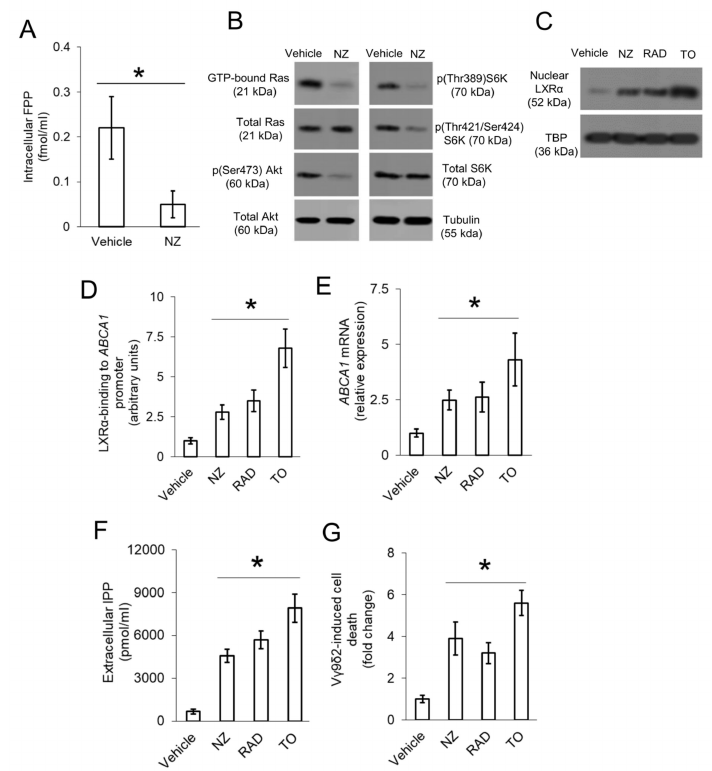
Figure 3. ABCA1 is down-regulated by Ras / Akt / mTOR and restored by Liver X Receptor α (LXR α ) activation in resistant osteosarcoma cells. 3D U-2OS cells were treated with sterile physiological solution (vehicle) or self-assembled nanoparticles encapsulating zoledronic acid (NZ), containing 1 µ M zoledronic acid for 24 h. When indicated, the mTOR inhibitor Everolimus (RAD001) (RAD; 10 nM) or the LXR α activator TO901317 (TO; 100 nM) were added for 24 h. ( A ) Cells were radiolabeled 24 h with [ 3 H]-acetate. The activity of farnesyl pyrophosphate synthase (FPPS), taken as an index of de novo synthesis of [ 3 H]-FPP, was measured by thin-layer chromatography (TLC) separation and liquid scintillation, in duplicates. Data are means ± SD (n = 3 independent experiments). * p < 0.001 for NZ-treated vs. vehicle-treated cells. ( B ) Pull-down assay of GTP bound-Ras and immunoblotting of the indicated proteins in whole-cell extracts. The β -tubulin expression was used as control of equal protein loading. The figure is representative of one out of three experiments. ( C ) Immunoblotting of LXR α in nuclear extracts. The TBP expression was used as control of equal protein loading. The figure is representative of one out of three experiments. ( D ) LXR α binding to ABCA1 promoter, measured by chromatin immunoprecipitation (ChIP) in triplicates. Data are means ± SD (n = 3 independent experiments). * p < 0.001 for all treatments vs. vehicle-treated cells. ( E ) ABCA1 mRNA levels, measured by qRT-PCR in triplicates. Data are means ± SD (n = 3 independent experiments). * p < 0.001 for all treatments vs. vehicle-treated cells. ( F ) IPP e ffl ux, measured after metabolic radiolabeling, in duplicates. Data are means ± SD (n = 3 independent experiments). * p < 0.001 for all treatments vs. vehicle-treated cells. G. V γ 9 δ 2 T-lymphocyte killing activity, measured as a percentage of Annexin V / Propidium Iodide-positive target cells, detected by flow cytometry, in duplicates. Data are means ± SD (n = 3 independent experiments). * p < 0.001 for all treatments vs. vehicle-treated